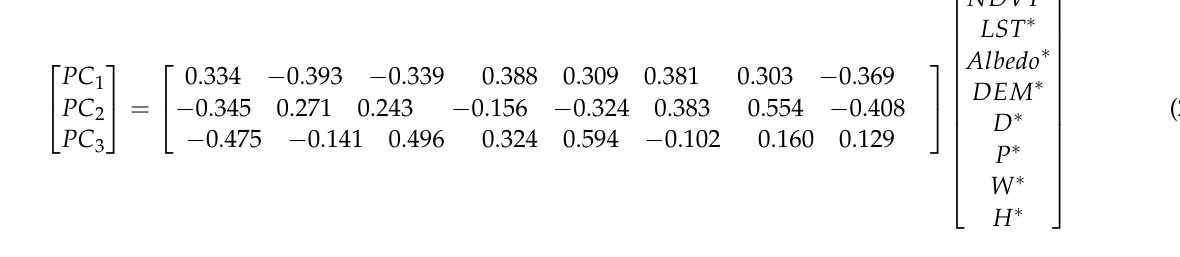
Table 3. Eigenvalues and variance contribution rates of the